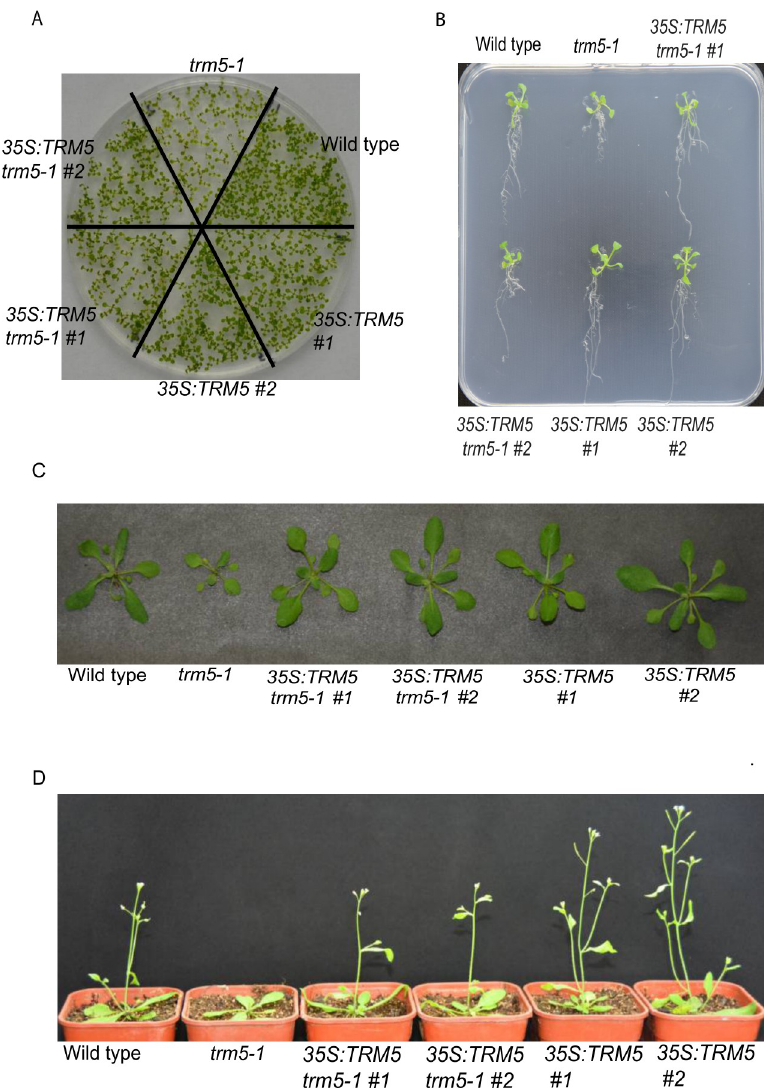
Fig 2. Phenotype analysis of trm5 , complemented lines (35S:TRM5 trm5-1 ) and TRM5 overexpression lines (35S: TRM5). ( A ) Seedlings were sown on ½ MS media plates and grown for 7 days and photographed. ( B ) Seedlings of wild type, trm5 , complemented lines (35S:TRM5 trm5-1 ), TRM5 overexpression lines (35S:TRM5) were vertically grown on ½ MS medium for 10 days and then photographed. ( C ) Plants were grown on soil under long day photoperiods and photographed 15 days after germination. ( D ) Wild type, trm5-1 , two complementing (35S:TRM5 trm5-1 ) and two overexpressing lines (35S:TRM5) were grown under long days and representative plants photographed at flowering.